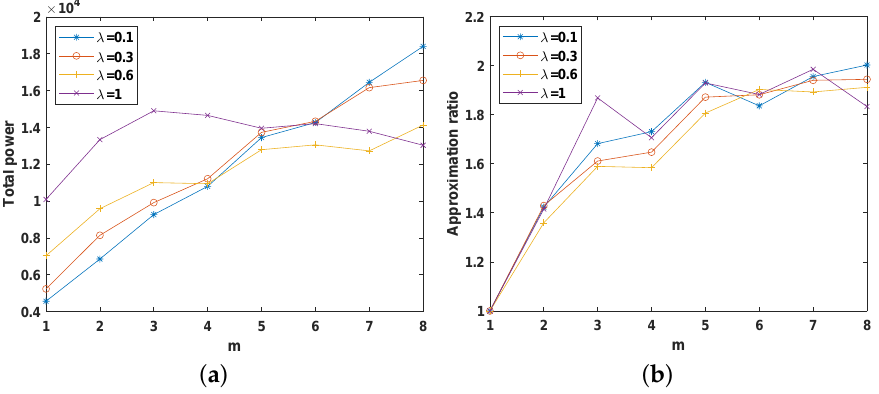
Figure 4. System performance with different numbers of servers and values of λ . ( a ) Total power. ( b ) Approximation ratio.